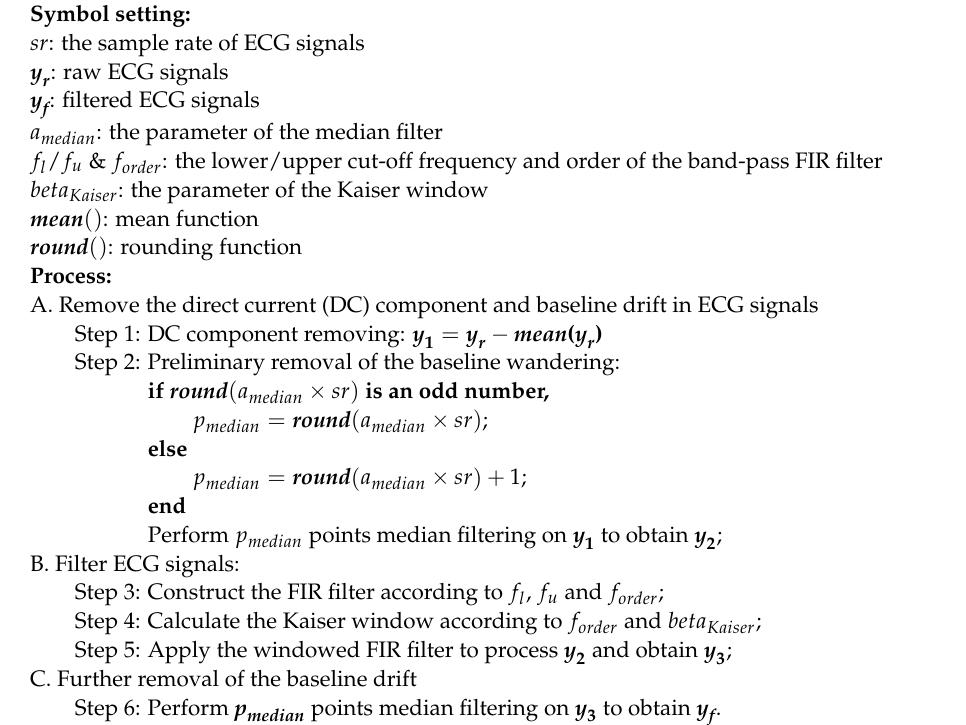
Algorithm 1 The proposed ECG preprocessing algorithm: Primary